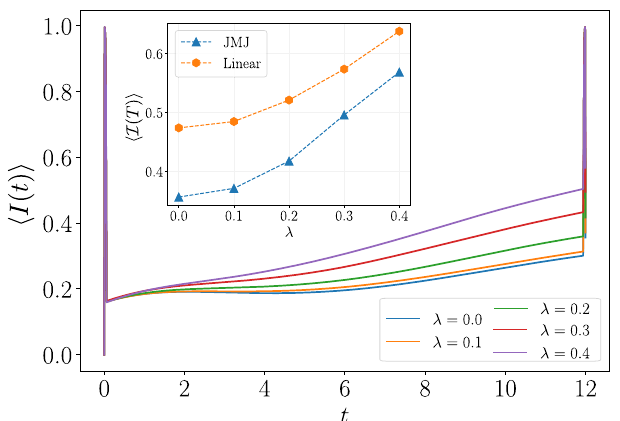
FIG. 8. Main panel: disorder averaged instantaneous infidelity (cid:5) I ( t ) (cid:4) of the optimal JMJ protocol from the clean wire in regime (I) for different disorder strengths λ . The jumps are robust against weak disorder whereas the infidelity increases during the move part of the protocol. The disorder averaging is done over 500 realizations. Inset: the final infidelity values (cid:5) I ( T ) (cid:4) increase approximately quadratically with disorder strength for both a lin- ear as well as the best JMJ protocol. For all disorder strengths the JMJ protocol outperforms the linear protocol. The other param- eters for these simulations are the same as in Fig. 2 and the parameters of the JMJ protocol can be found in Appendix